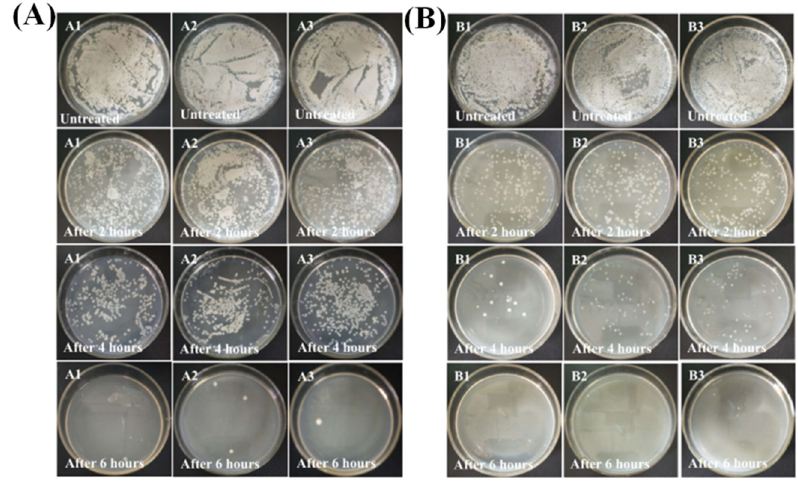
Figure 5. ( A ) Photographs of E. coli after different treatment times (0, 2, 4 and 6 h). ( B ) Photographs of S. aureus after different treatment times (0, 2, 4 and 6 h). A1–A3 and B1–B3 represent three parallel experiments.